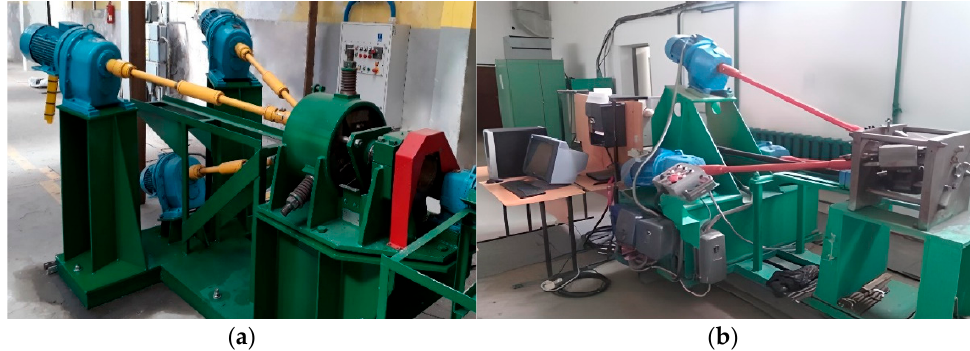
Figure 1. The used radial shear rolling mills ( a ) RSP-14/40 (PCz, Poland); ( b ) RSP-10/30 (KSU,